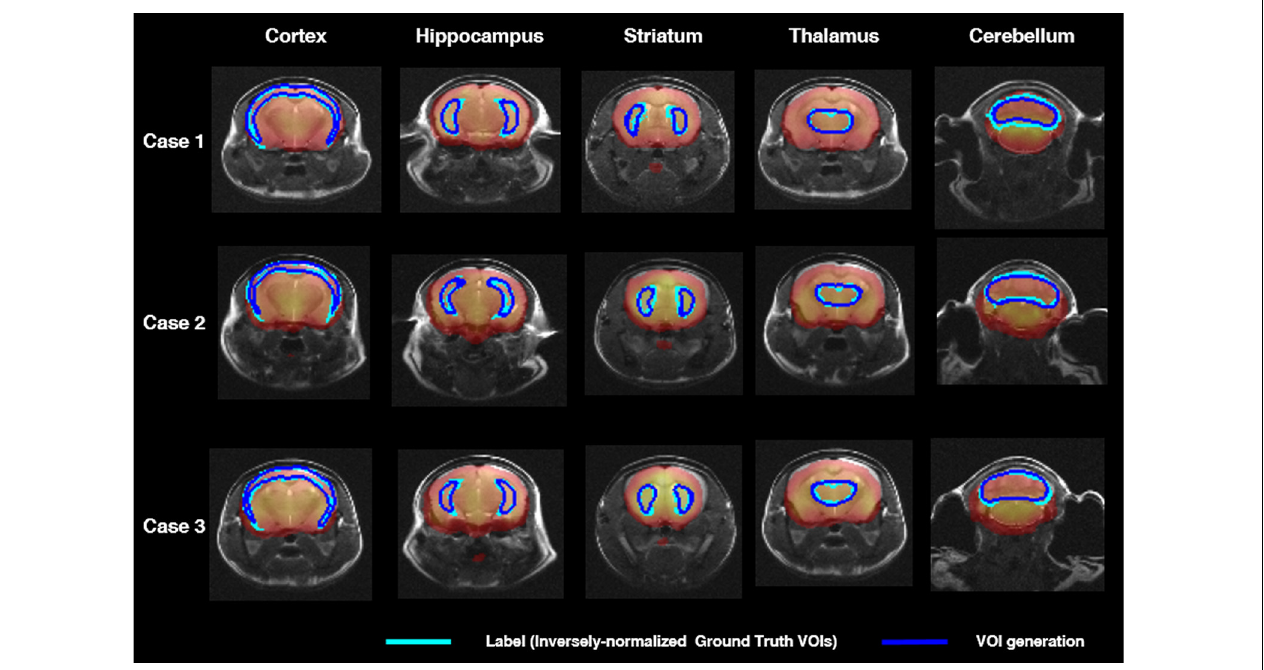
FIGURE 3 | Segmentation comparison of target VOIs (i.e., cortex, hippocampus, striatum, thalamus, cerebellum) in axial plane of three mice. The light blue contour represents deep learning label masks which are iVOI templates. The blue contour represents an iVOI template in an individual space generated by the proposed deep CNN. iVOI, inversely normalized VOI; deep CNN, deep convolutional neural network.